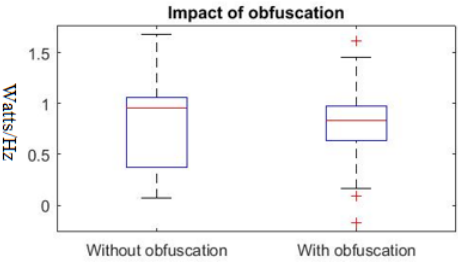
Figure 8. Statistical significance and impact of obfuscation of three features ( {𝒻 1 , 𝒻 2 , 𝒻 3 } ) in F test and F Prv respectively.